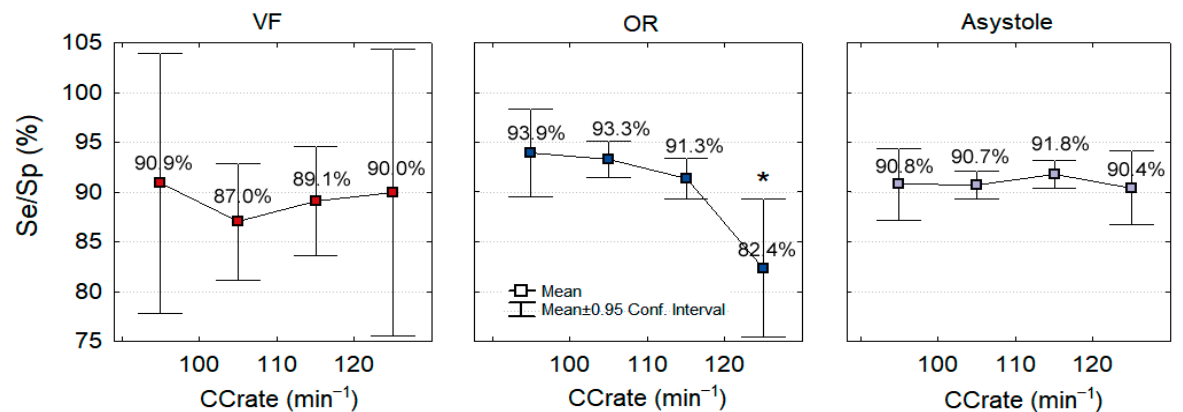
Figure 13. Dependency of CNN3-CC-ECG network performance on the CC rate in the test database. The mean value and 95% confidence interval of Se (VF) and Sp (OR, Asystole) are presented in function of four CC rate ranges: slow (<100 min − 1 ), normal (100–110 min − 1 , 110–120 min − 1 ) and rapid compressions (>120 min − 1 ). Significant drop of performance is highlighted for Sp (OR) at CC rate >120 min − 1 (* p <